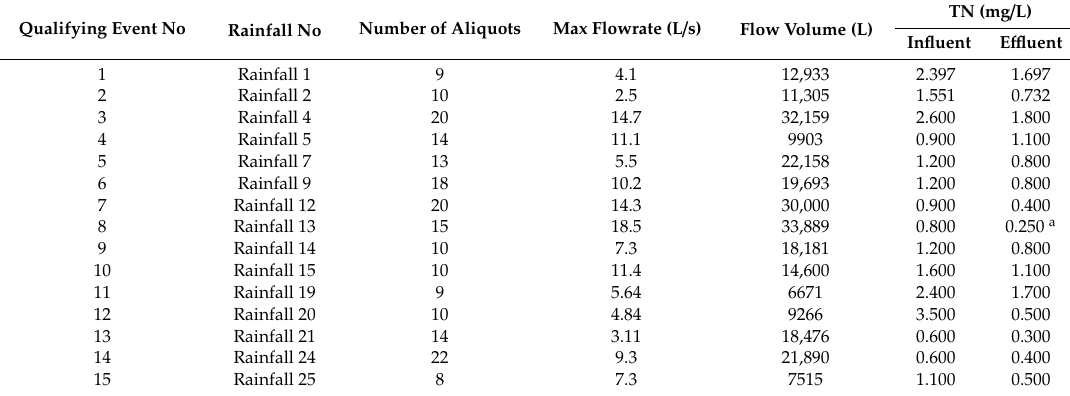
Table A3. TN influent and e ffl uent results ( LOD = 0.1 mg / L).